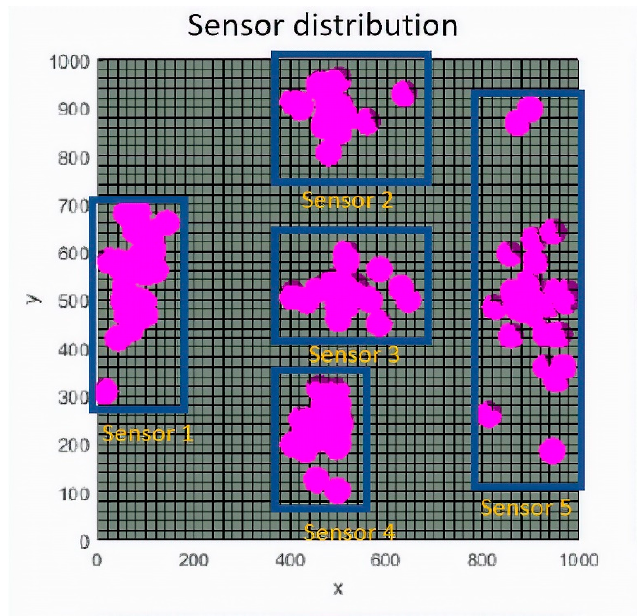
Figure 8. Sensor distribution in the x-y plane in meters. Each sensor defines an environment where convergence always happens during the optimization process with independence on the initial random population. In this figure the result of 48 different optimizations is represented.